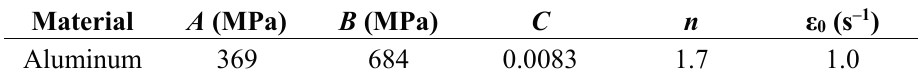
Table 4. Parameters of Aluminum in Johnson–Cook model.